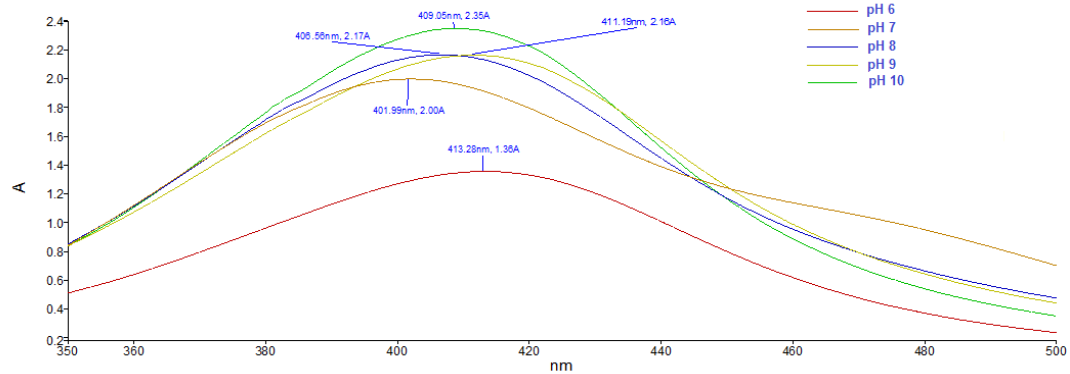
Figure 1. UV-Vis spectra of silver nanoparticles at different pH values.